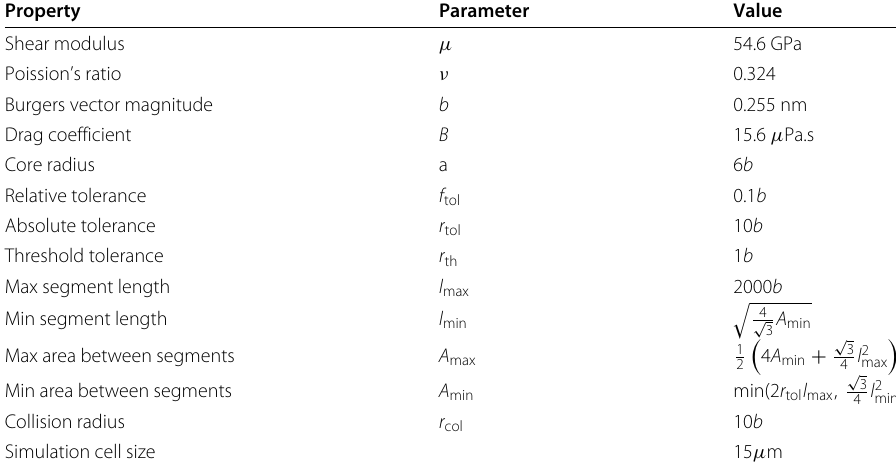
Property Parameter Value Shear modulus μ 54.6 GPa Poission’s ratio Burgers vector magnitude b 0.255 nm Drag coefficient Core radius Relative tolerance f tol Absolute tolerance r tol Threshold tolerance Max segment length Min segment length Max area between segments Min area between segments Collision radius Simulation cell